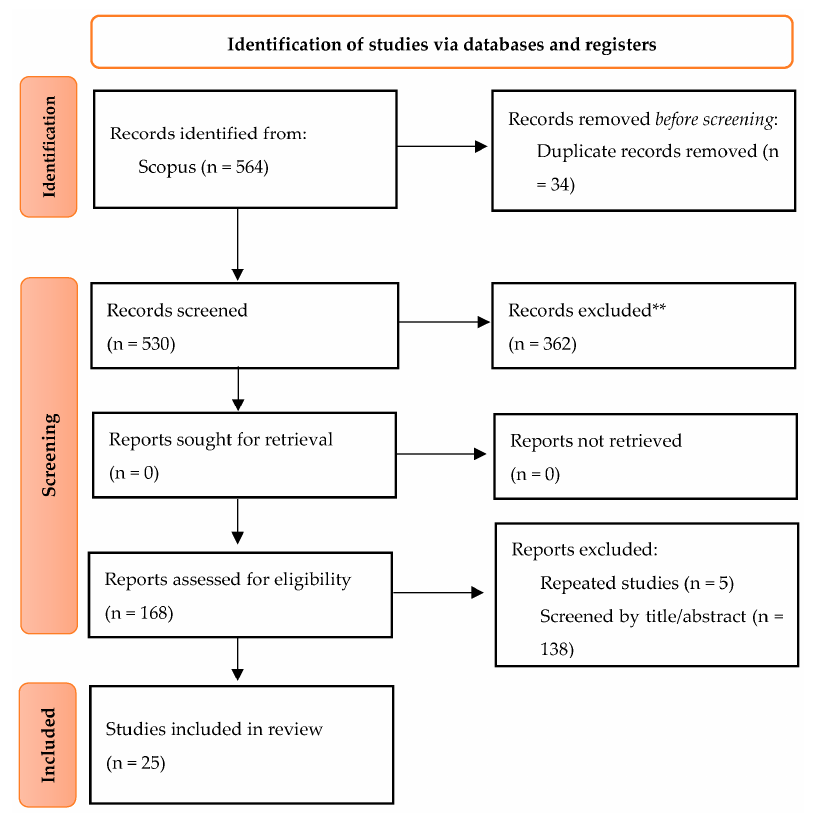
Figure 3. Flowchart of the PRISMA literature search method. ** Number of papers excluded from the review according to the defined criteria.